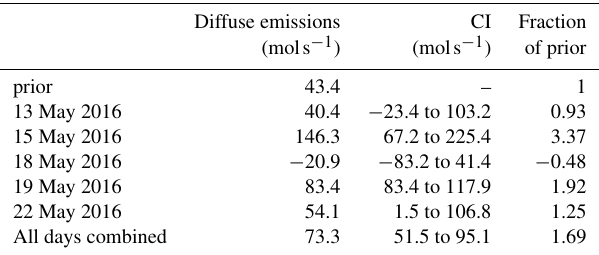
Table 4. Inversion results for the diffuse sector for all 5d of the cam- paign; 95% confidence intervals are computed using the posterior error